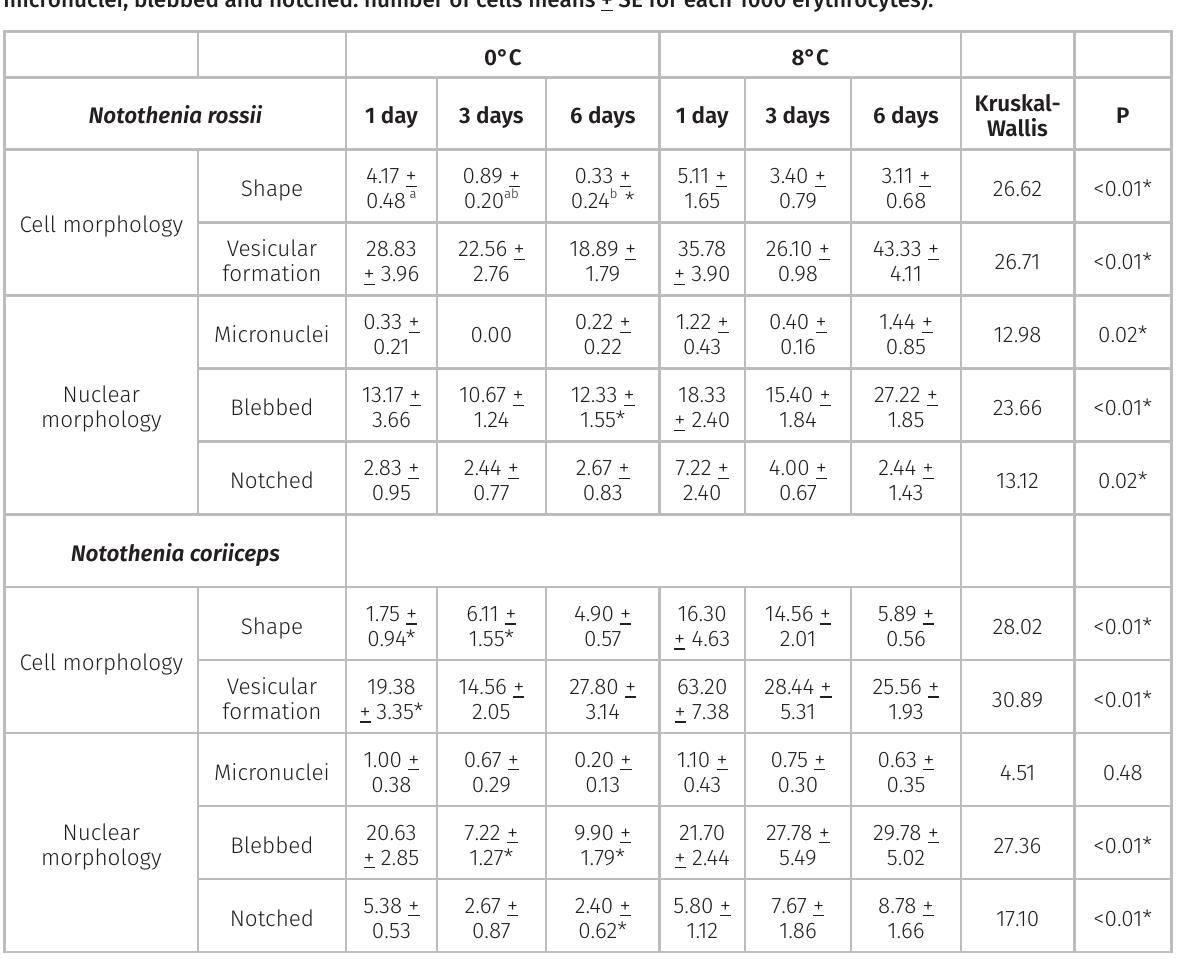
The asterisks indicate differences between the temperatures, and lowercase letters indicate differences between the times. The results of the Kruskal-Wallis statistical test and respective P are